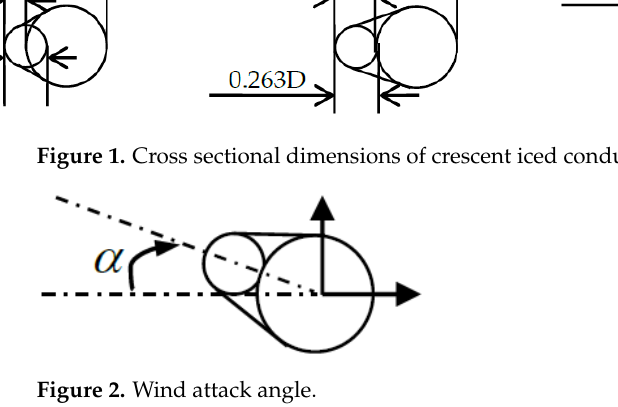
Figure 2. Wind attack angle.